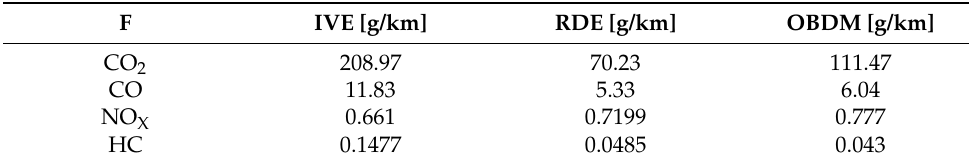
Table 5. Average Emission Factors .